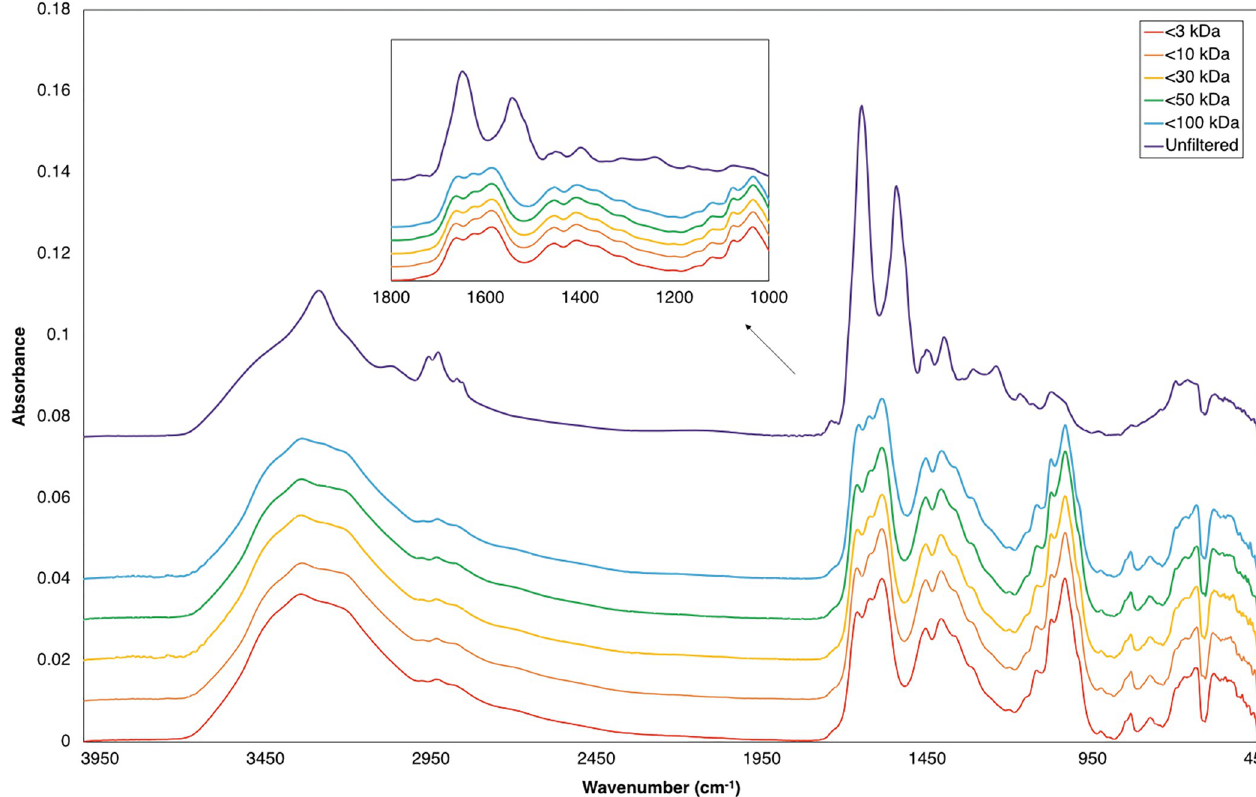
Fig 1. Example of patient serum spectra including unfiltered whole serum and each molecular weight region. Average of the 30 GBM patients shown here. The inset is the wavenumber region between 1800 cm -1 and 1000 cm -1 , which was used for all chemometrics and machine learning analyses. Spectra is offset for clearer